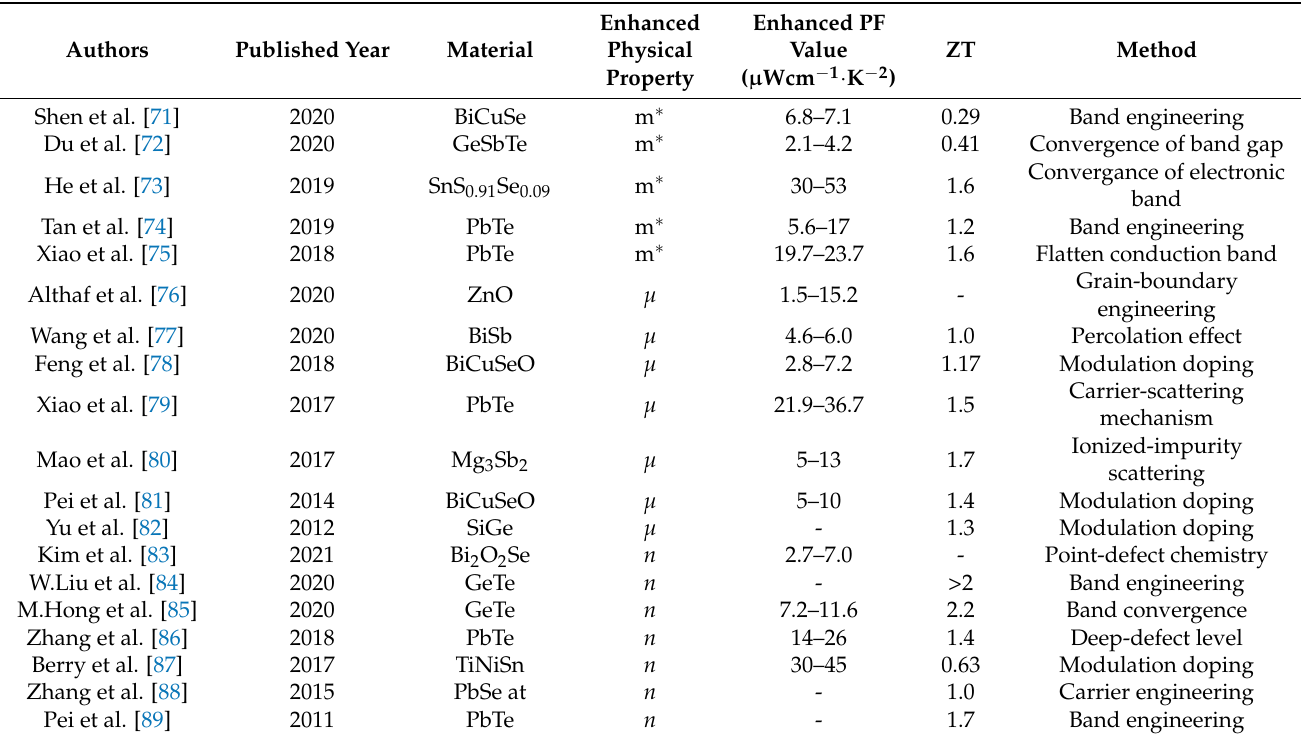
Table 3. Different advanced approaches in enhancing PF, clustered based on the enhanced physical properties (m ∗ , n , and µ